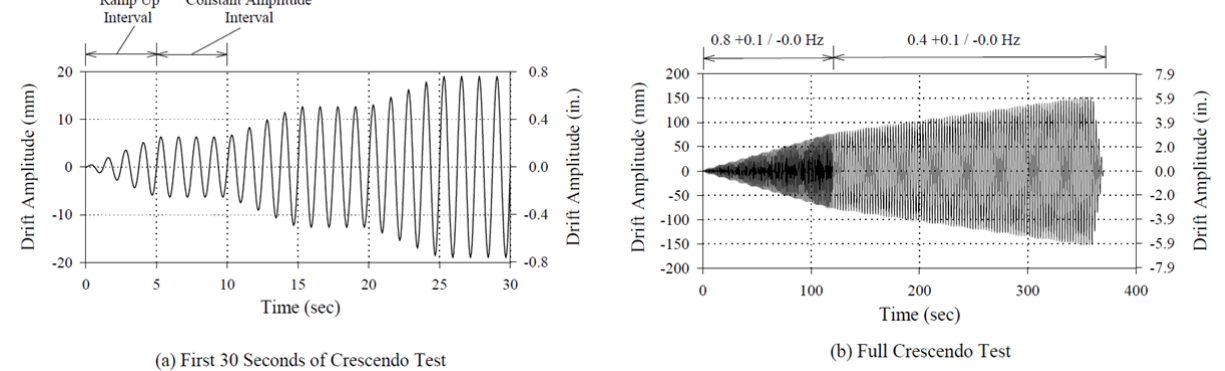
Fig. 2 Displacement time history for the Crescendo test (AAMA